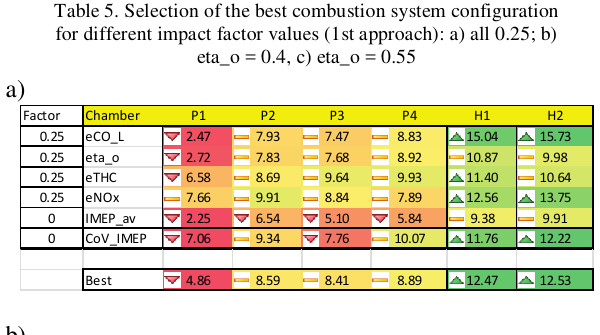
Table 5. Selection of the best combustion system configuration for different impact factor values (1st approach): a) all 0.25; b)